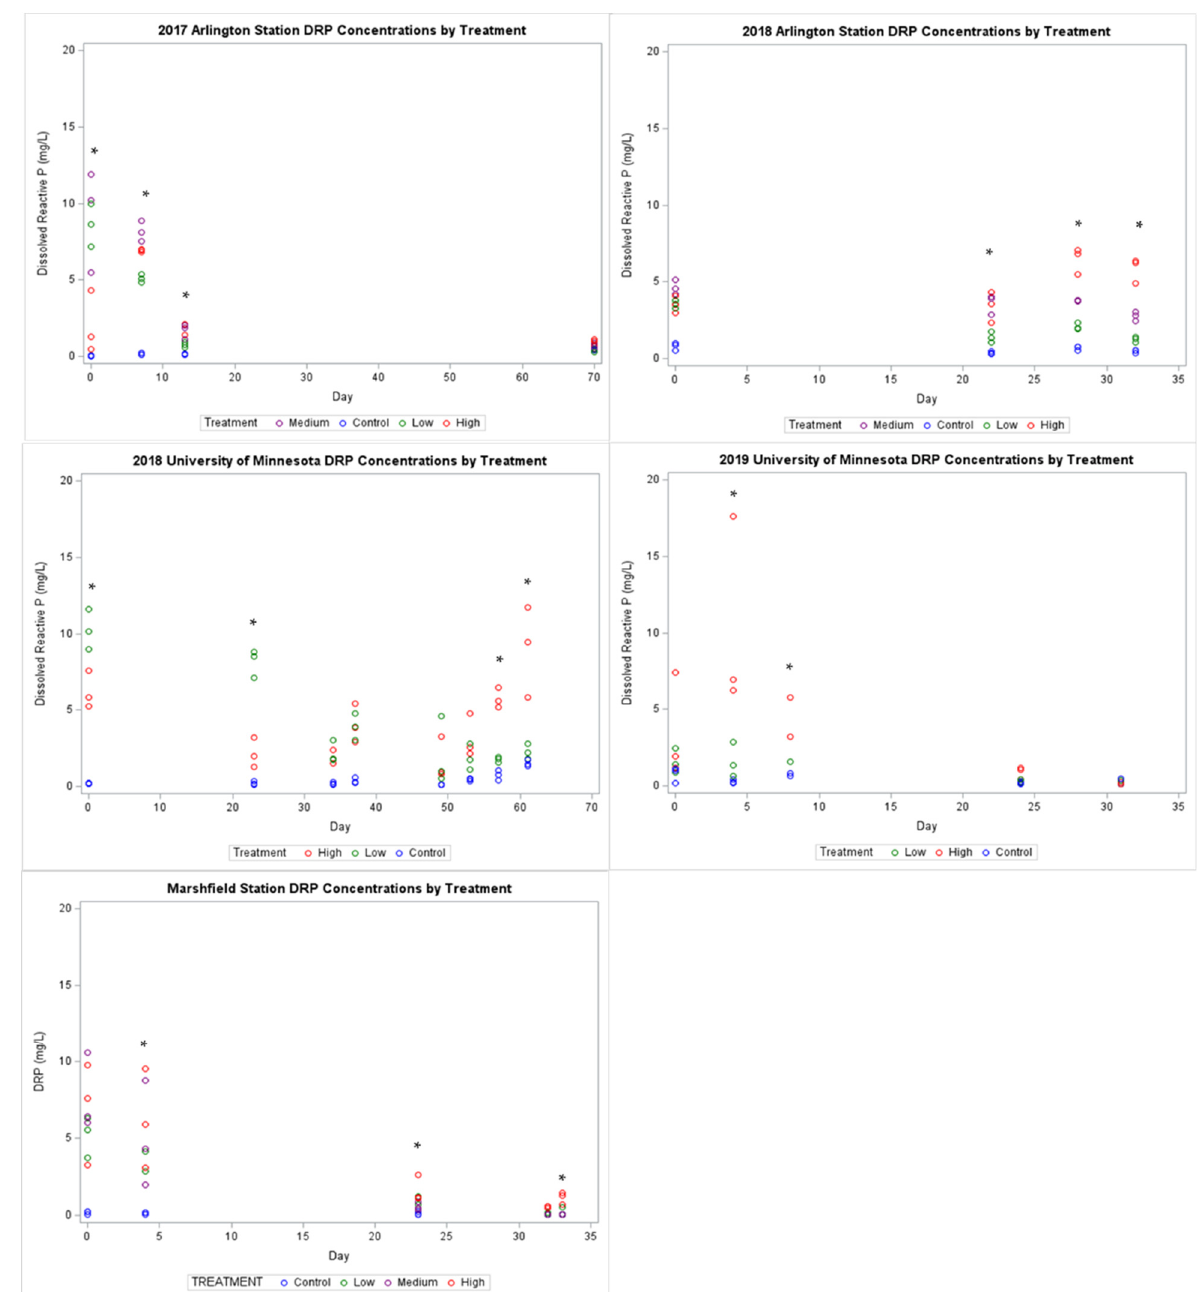
Figure 3. Dissolved reactive phosphorus (DRP) concentrations by treatment for each site and year of the experiment. Asterisks indicate a significant ( p ≤ 0.05) main effect of manure solids content. At Marshfield, the average High treatment DRP concentration was significantly